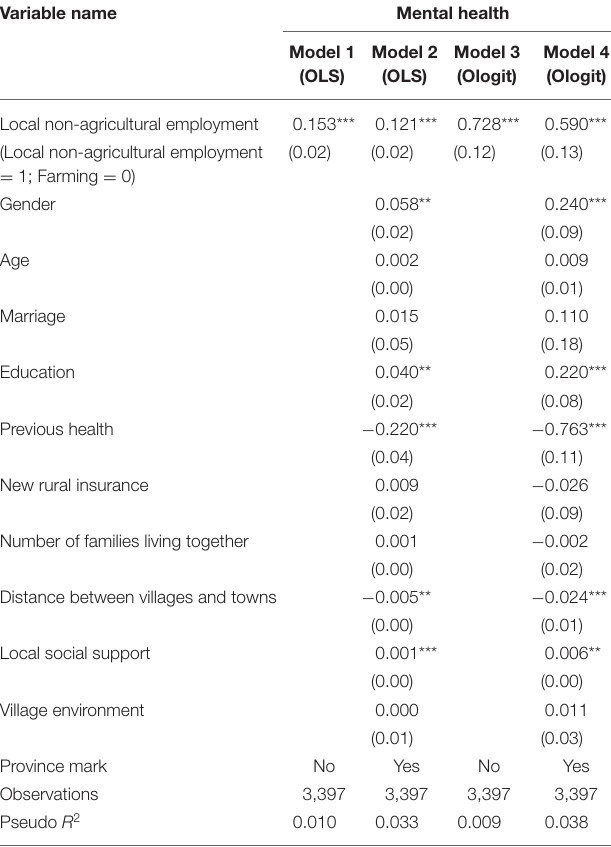
TABLE 2 | Basic regression